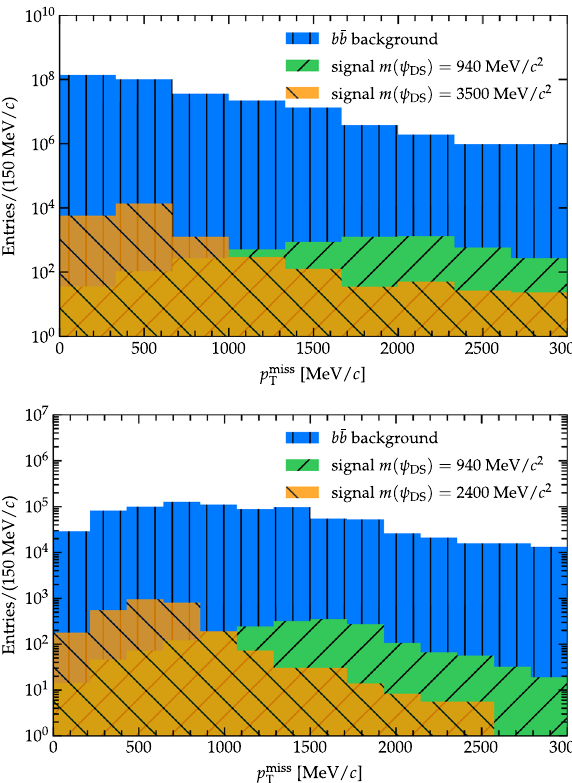
Fig. 2 Normalised distributions of the reconstructed invariant mass of Fig. 3 Distributions of p miss + Σ ( ∗ ) ± → Λ 0 ( → ψ )π ± candidates in the simulated samples. h − DS h b b 1 2 grounds. Top: B 0 → ψ DS Λ( 1520 ) . Bottom: B + → ψ DS Λ c ( 2595 ) + . The mass of the Λ b baryon is a fixed parameter in this case. Hatched Blue: background from inclusive b ¯ b events. Orange: signal for a high + π − candidates. → ψ green:signal,blue: b ¯ b background.Top: Λ 0 DS K b mass (close to phase space limit) dark baryon. Green: signal for a dark → ψ π + π − candidates.Thetaggingof Λ 0 Bottom: Λ 0 allowsaclear DS b b baryonat940MeV / c 2 .Thesignalandbackgroundyieldscorrespondto those expected at LHCb at 15 fb − 1 , with the signal branching fractions assumed to be those that could be excluded at 95% CL (see Sect. 4). No systematic uncertainties are assumed in these